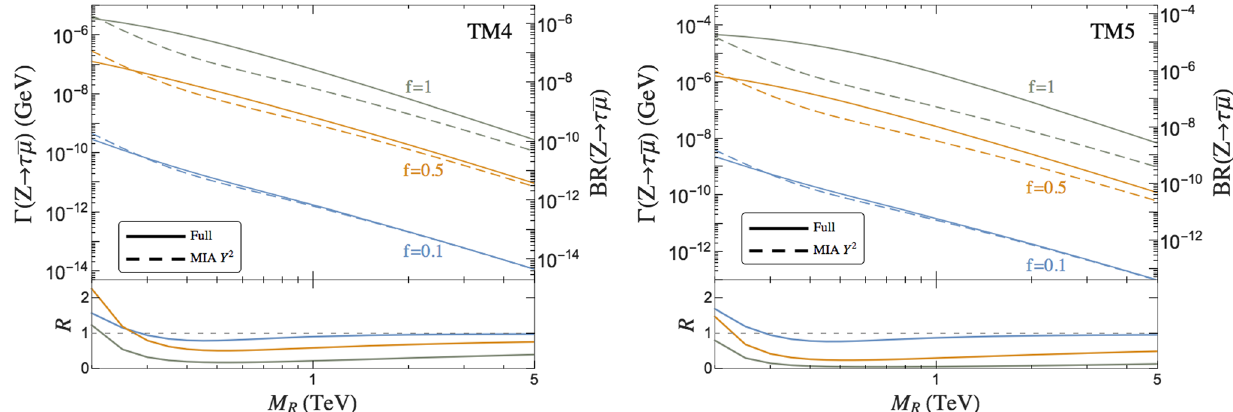
Fig. 5 Predictions for the partial width (cid:5)( Z → τ ¯ μ) and branching ratio BR ( Z → τ ¯ μ) as a function of M R . The dashed lines are the pre- dictions from the MIA to O ( Y 2 ν ) . The solid lines are the predictions from the full one-loop computation of the mass basis. Here the exam-